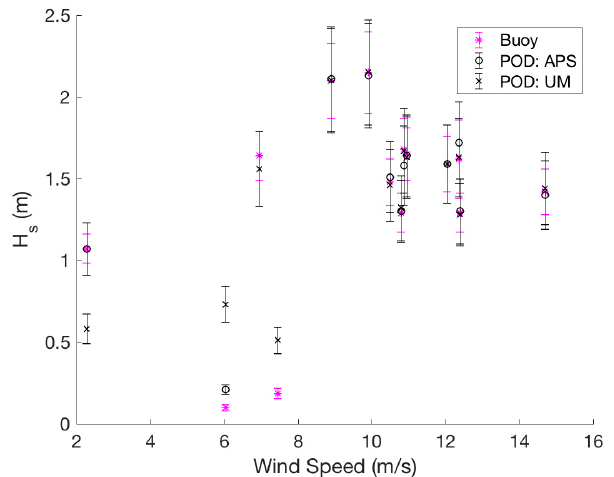
Figure 5. H s estimates with 95% confidence intervals for the radar-based POD method (black) along with buoy-measured estimates (magenta asterisks) for the APS radar ( ) and the UM radar ( ✖ ) versus wind speed.